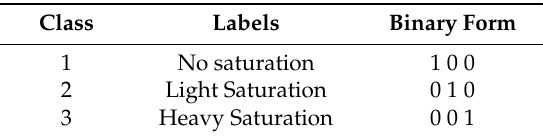
Table 4. Binary target values using one-hot